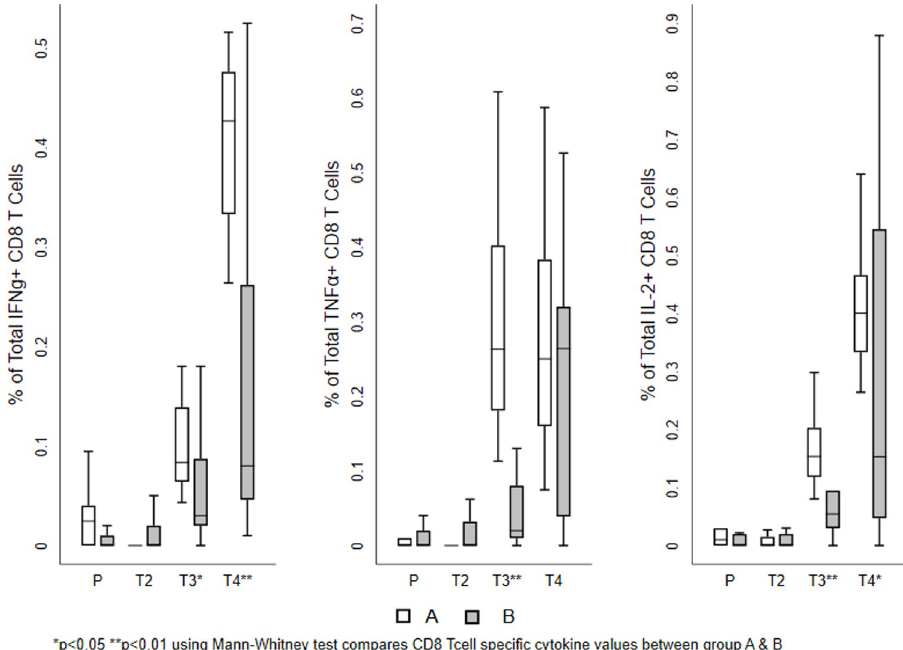
Fig 4. Vaccine-induced HIV-1-specific CD8 + T cell responses. Frequency of vaccine-specific CD8 + T cells at different time points. The mean value of the total responses (Env, Gag, and Pol) obtained for each T cell sub population is shown. (A) Frequency of IFN- γ positive vaccine induced T cell subsets. (B) Frequency of TNF- α positive vaccine induced T cell subsets. (C) Frequency of IL-2 positive vaccine induced T cell sub populations. The box plots show the distribution of responses in positive responders only. The boxes indicate the median (solid line), mean (dashed line), and interquartile range (IQR). P values for significant differences were determined using the Mann- Whitney T test and are represented using the symbol � . (Note: P-Placebo, T2-Prevaccination, T3-Second week after first MVA vaccination, T4-Second week after last MVA vaccination).